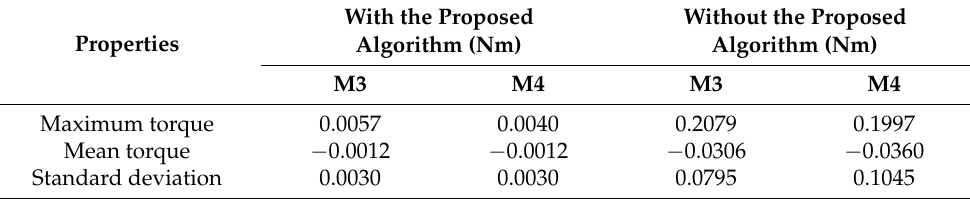
Table 4. Estimated torques of M3 and